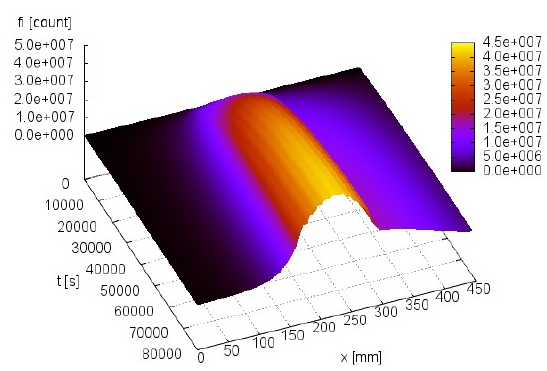
Figure 7. Neutron flux distribution for energy group 2 MeV in Case 2 (nuclear system is stabilized after subcritical multiplication for k eff = 0 . 982 693).